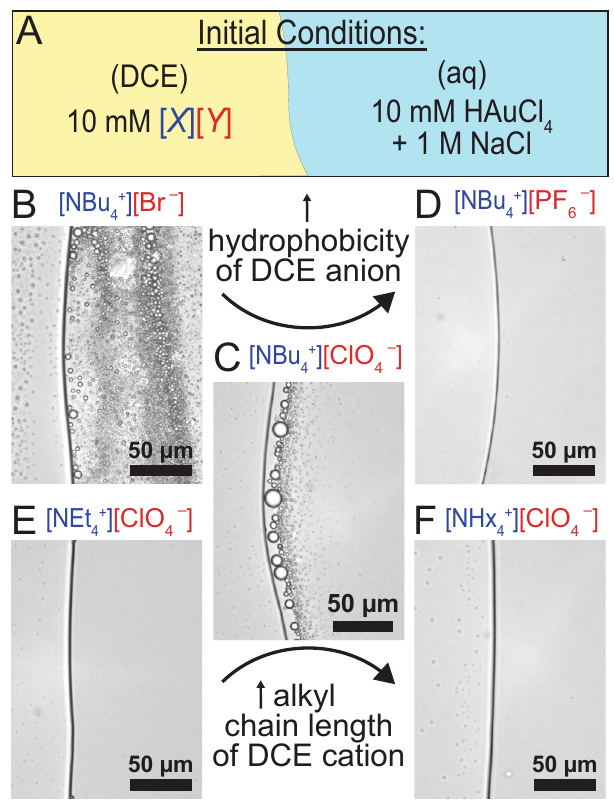
Fig. 4 | Effect of organic-phase electrolyte on emulsi fi cation behavior. A Gra- phic showing initial conditions where the DCE phase contains 10mM of a non- aqueous salt with variable cation ( X ) and anion ( Y ), while the aqueous phase contains 10mM HAuCl 4 +1M NaCl. B – F Light microscope images showing the liquid|liquid interface after 10min from initial contact of the two phases. All images show the DCE phase on the left and the aqueous phase on the right. For B – D ,tetrabutylammonium(NBu 4 + )saltswereusedintheDCEwiththeanionbeing Br – ( B ), ClO 4 – ( C ), or PF 6 – ( D ). For E and F , perchlorate salts were used in the DCE with the cation being tetraethylammonium (NEt 4 + , E ) or tetrahexylammonium (NHx 4 + , F ).All opticalmicrographs were taken with a ×40 NA0.60objective and a 500ms exposure